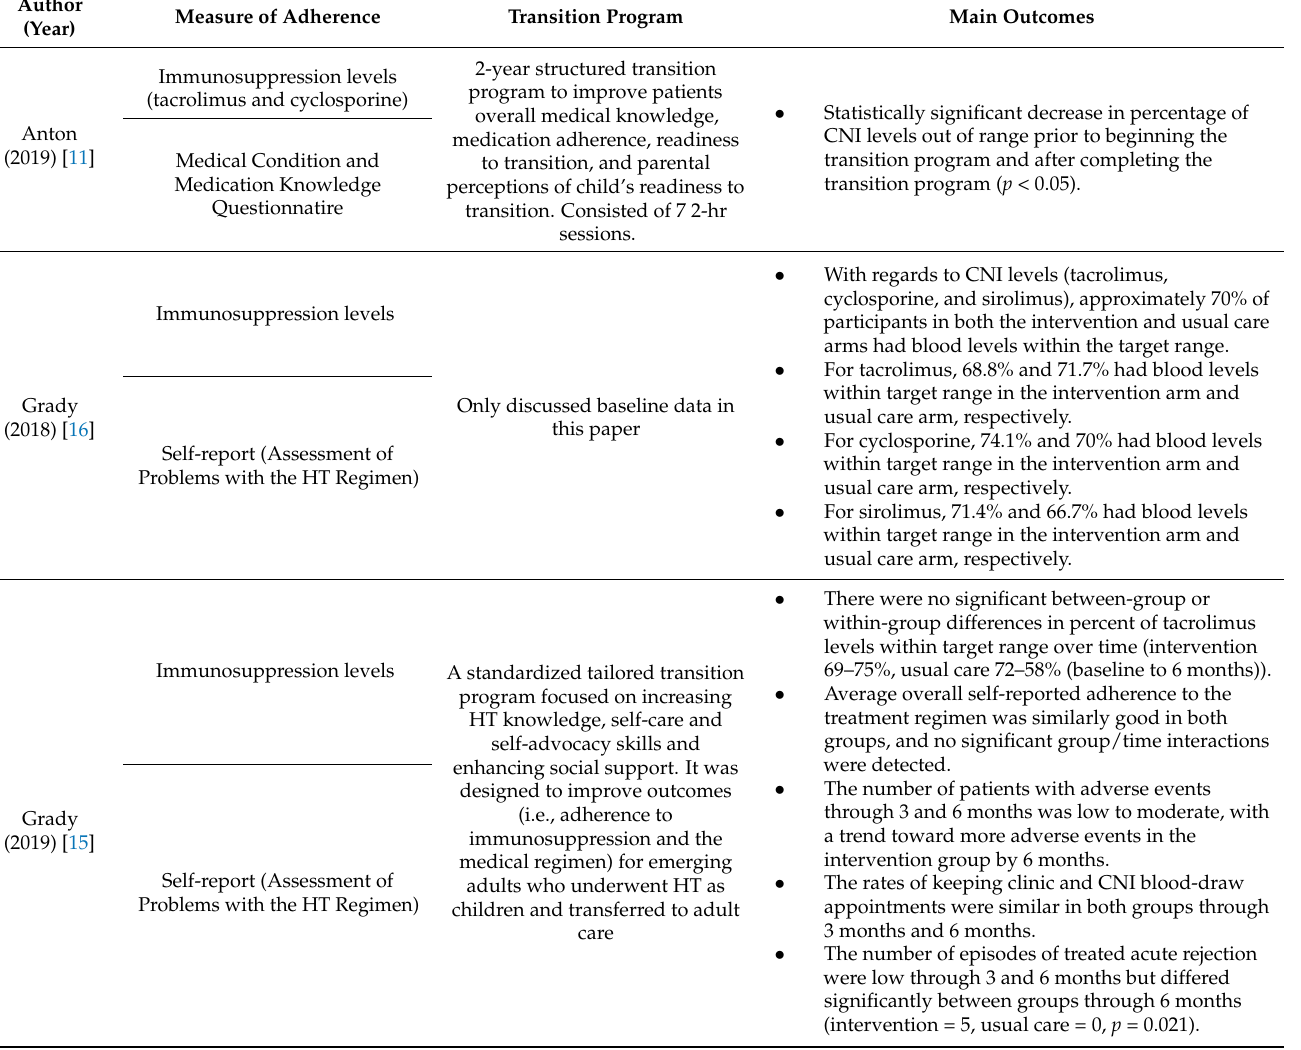
Table 5. Studies exploring the effect of a transition program on